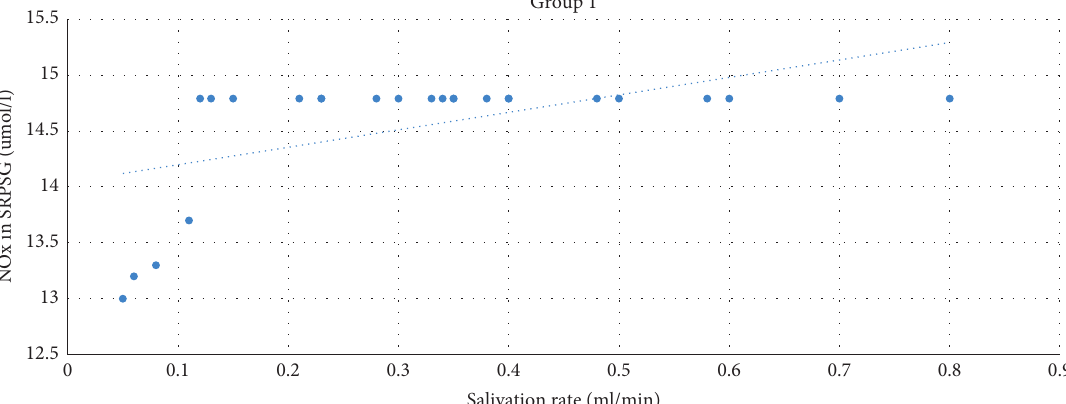
Figure 4: The correlation between the NOx level in SRPSG and the salivation rate among patients in Group 1.